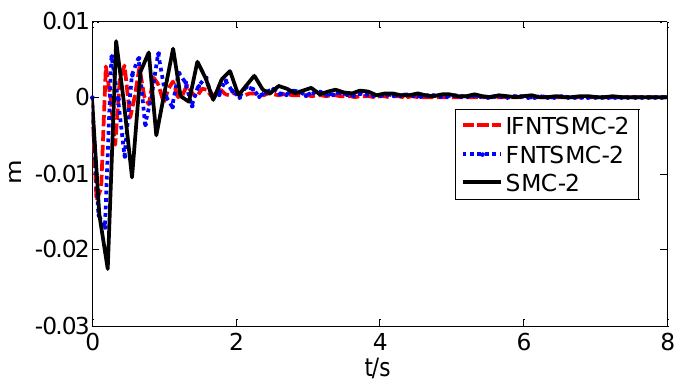
Figure 9. Control quantity of the motor in the experiment.